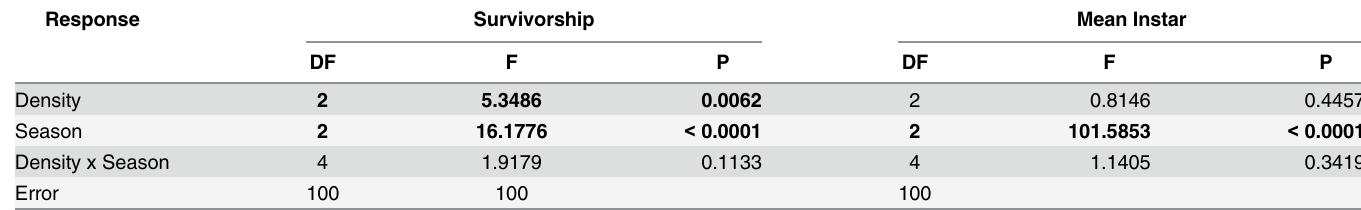
Table 5. Two-way ANOVA for the effect of Aedes albopictus density and season on the mean larval survivorship and developmental progress of Aedes aegypti after 7 days (mean instar).